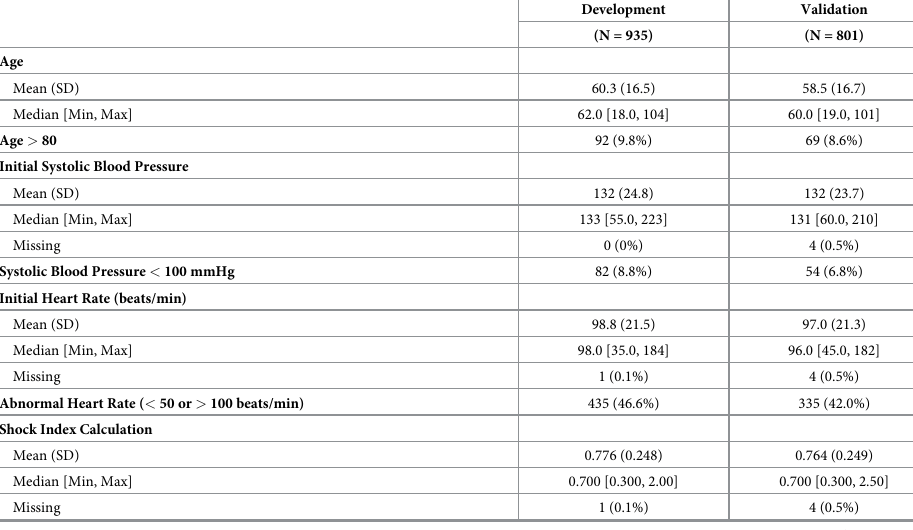
Table 1. Descriptive statistics of development and validation